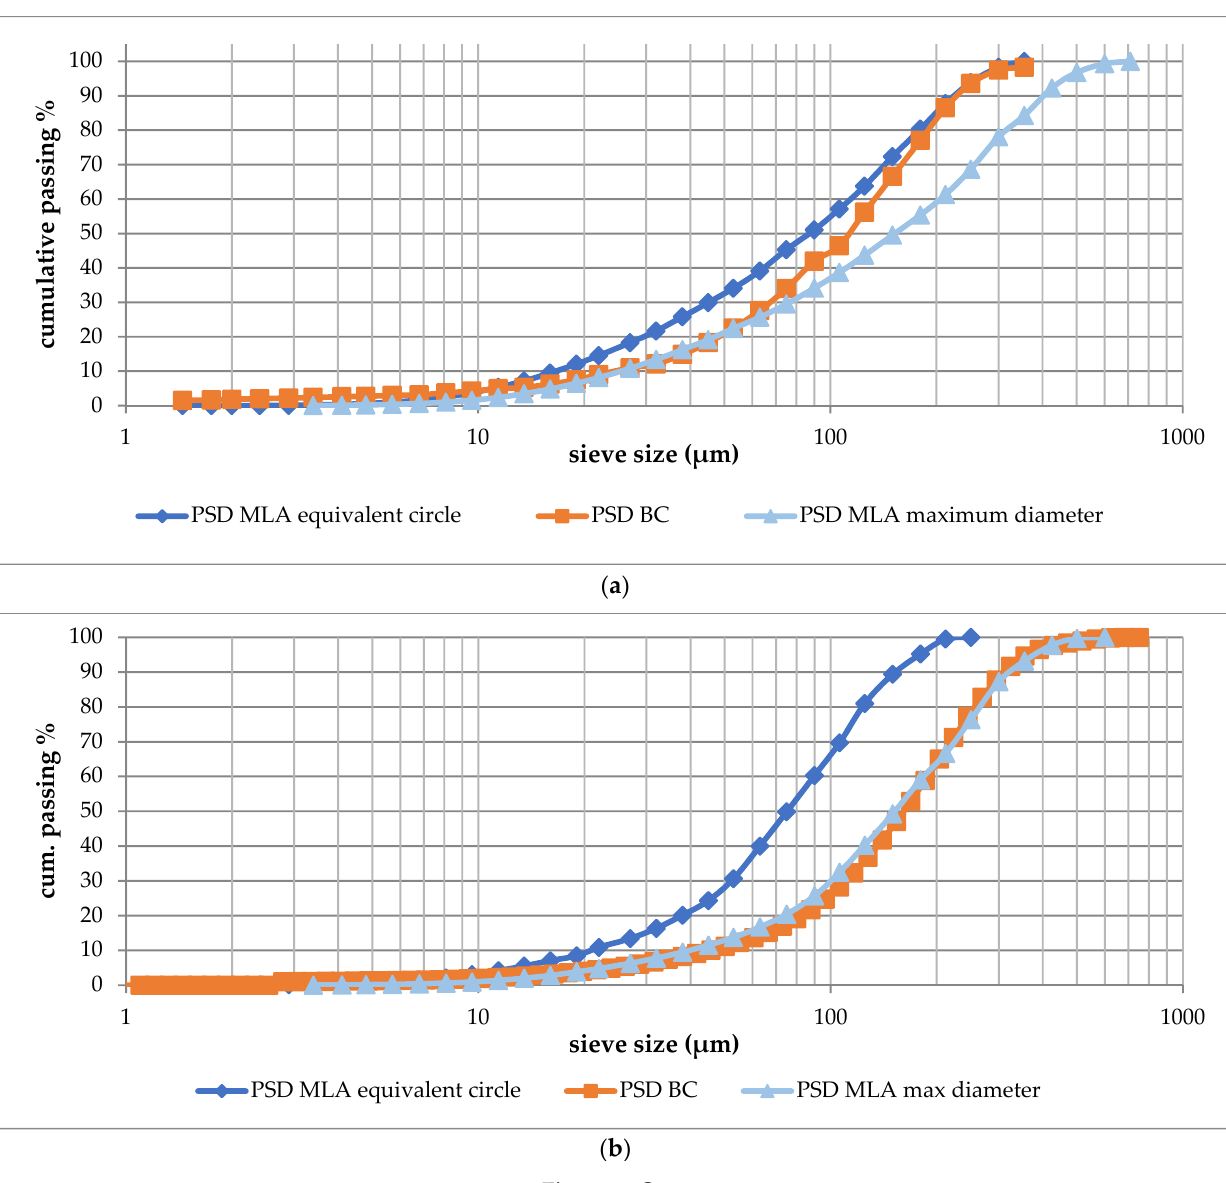
( c ) Figure 5. Particle size distribution curves (PSD) as measured by laser diffractometry (PSD BC) and calculated from MLA data (PSD MLA). ( a ) Leipzig, ( b ) Dresden, ( c ) Chemnitz. 4. Conclusions The main message from this data is: beware of method-specific misrepresentation. None of the analytical approaches shows the full spectrum; to date, ash still presents chal- lenges. However, methods can augment each other and ash studies should take the strengths and weaknesses of each method into account. ICP suffers from incomplete di- gestion, XRF from matrix effects and automated mineralogy does not report trace ele- mental data. When looking at particle size distributions (PSD), laser-supported PSD seems to overestimate the coarser end, as porous particles and agglomerations of the material hinder accurate detection. For ash, the high silicate content leads to elaborate sample preparation procedures for ICP-OES analyses. Thus, XRF analyses are encouraged as an addition for elemental composition data—since SEM-EDX analyses show complex material phases [10,24], it is advised to gather data by element, not oxides. The actual risk resulting from potentially toxic elements needs to be addressed carefully, depending on the use of ash. Ash behavior during technical processes may be studied on a particle morphological level using an au- tomated mineralogy system, which may also validate and assist with main element anal- ysis and particle size distributions. Comparing several laboratory analytical techniques,